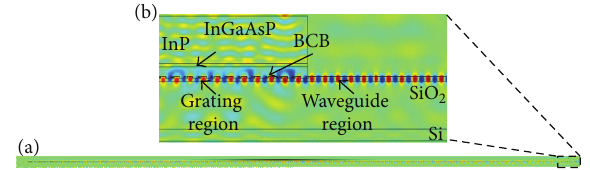
Figure 8: Optical field of the large-area binary blazed grating coupler bonded with the LED. (a) The optical field of the overall structure. (b) The optical field of the structure’s output terminal.